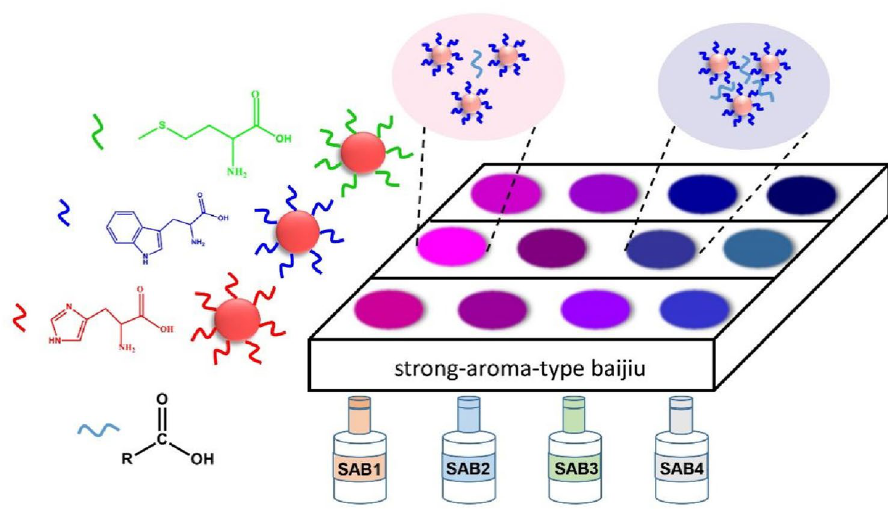
Figure 1. Colorimetric sensor array based on AA-modified AuNPs for recognition of Chinese